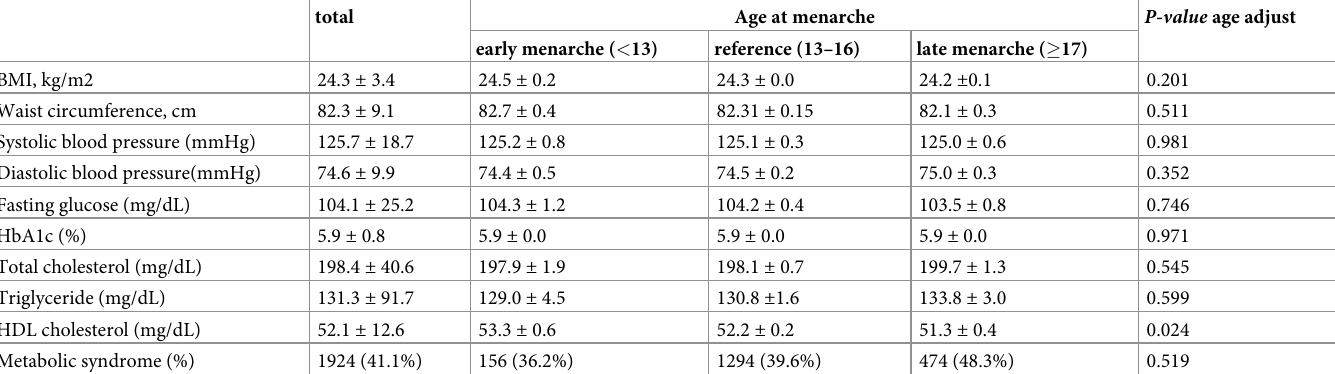
Table 2. Metabolic parameters of study participants by age at menarche.